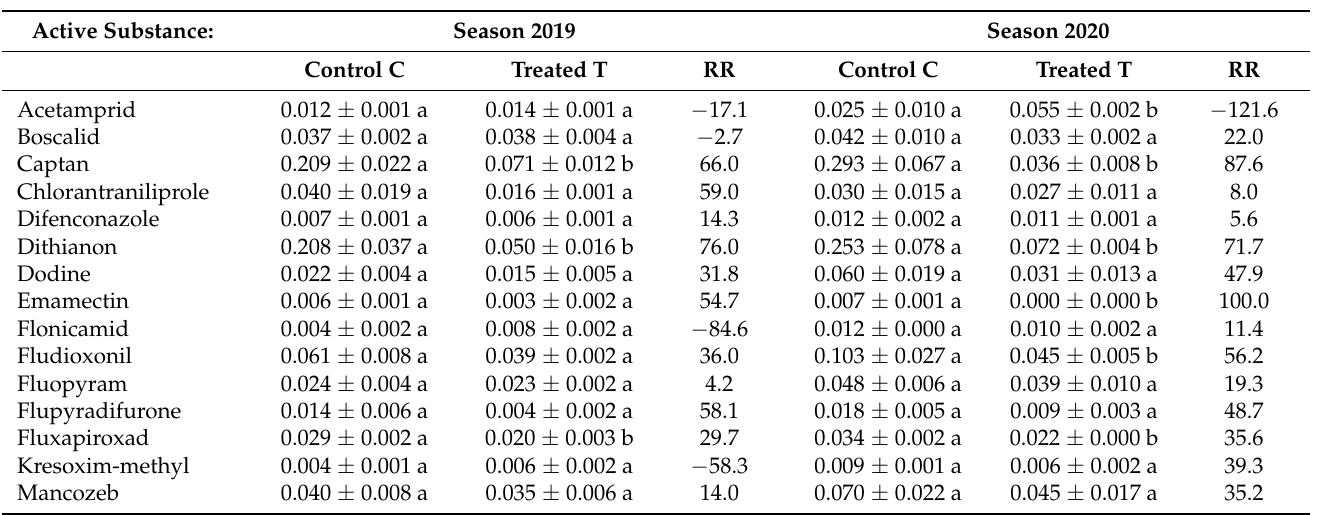
Table 3. Average concentration of pesticide residues ( ± SE) in apples at picking time (mg kg − 1 ) in relation to treatment with PBC (potassium bicarbonate); four times preharvest at a rate of 10 kg of VitiSan ® /1000 L